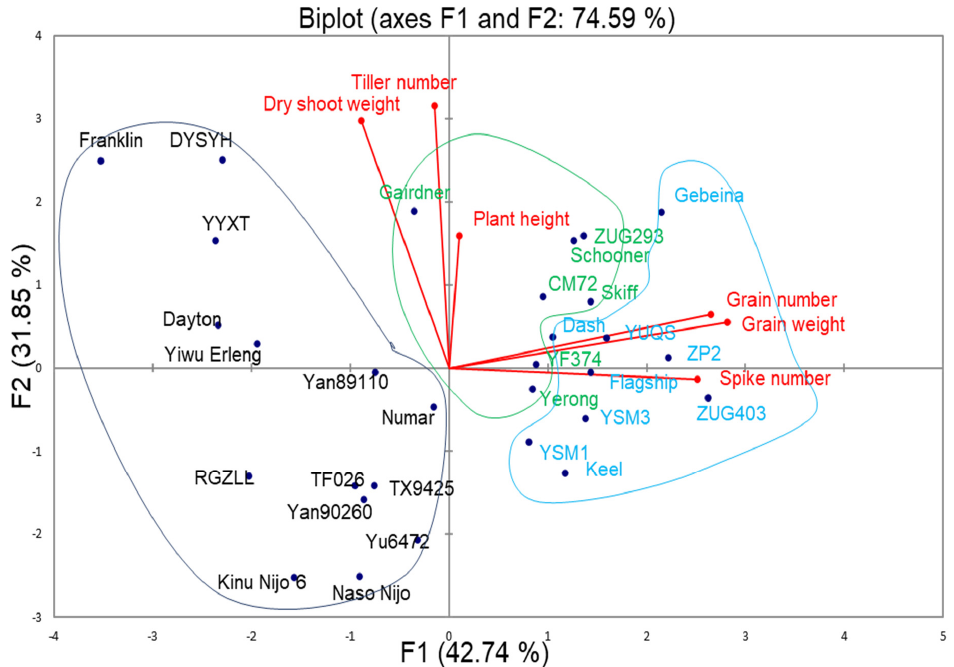
Figure 6. Principle component analysis for AX1 and AX2 for all data. The axes accounted for 74.8% of the sums of squares. Genotype groups correspond to the following colours: G#1, blue; G#2, green; and G#3, purple. Principal component analysis (PCA) was performed using traits mean values with Kaiser’s criterion (i.e., eigenvalue more than 1) using XLSTAT software.